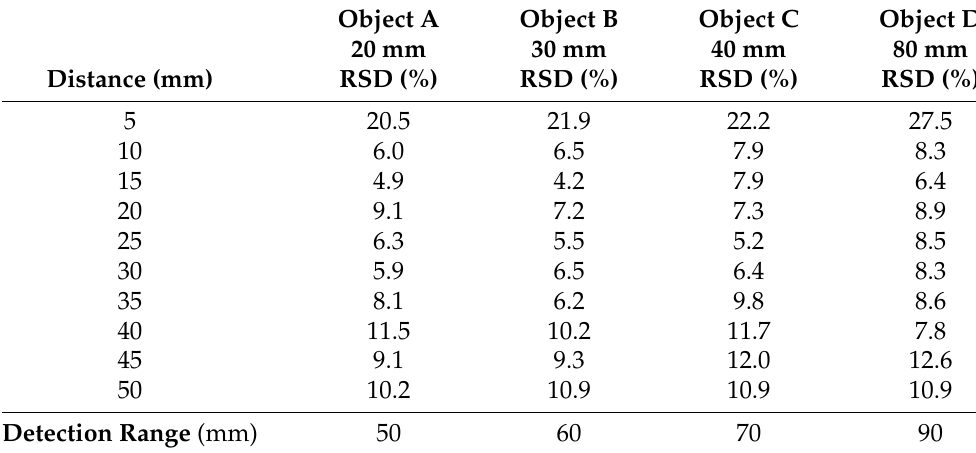
Table 1. Relative standard deviation (RSD) of capacitance density value at CoP on every height. The last row presents detection range of every square object. The values are height of the measurement point whose reconstructed capacitance density is closest to 3 × 10 − 7 F/mm 2